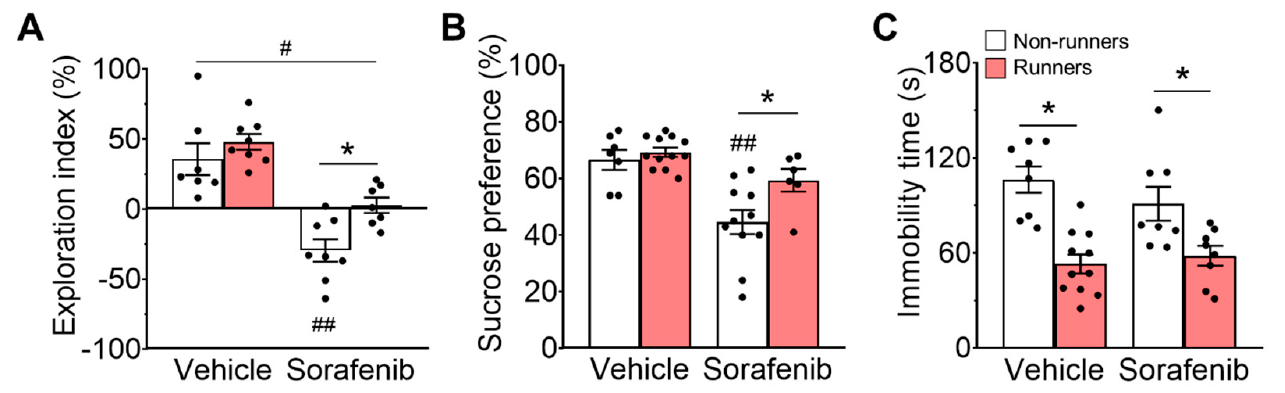
Figure 2 . Sorafenib administration impaired spatial memory and induced anhedonia-like behavior . Figure 2. Sorafenib administration impaired spatial memory and induced anhedonia-like ( A ) Sorafenib administration impaired spatial working memory in non-runners (Tukey’s post hoc: treated mice since they did not show any preferences for novel over familiar arms. Voluntary run-